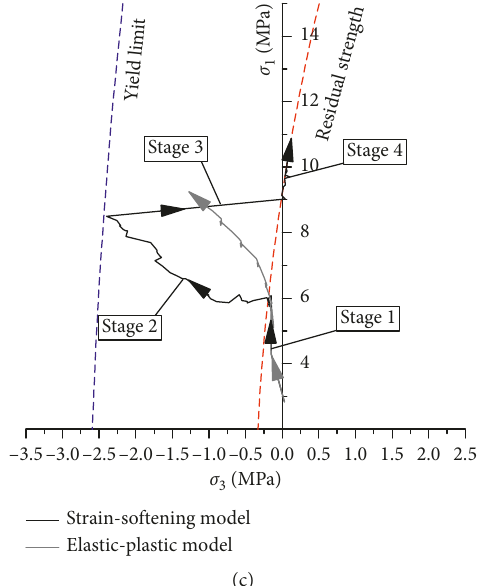
Figure 20: Stress path of the bedrock. (a) The support at the left end. (b) The support at the right end. (c)